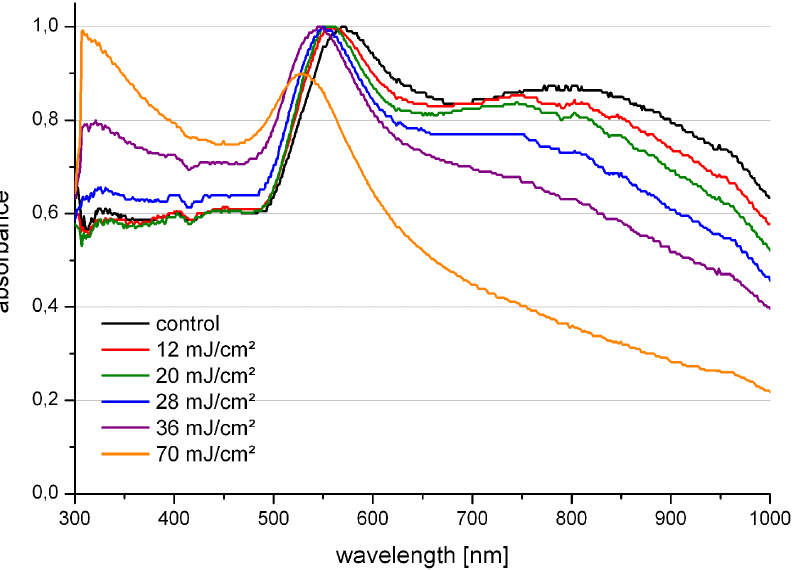
Figure 8. Absorbance spectra of 200 nm AuNP in RPMI after irradiation with different values of radiant exposure. doi:10.1371/journal.pone.0058604.g008 PLOS ONE |